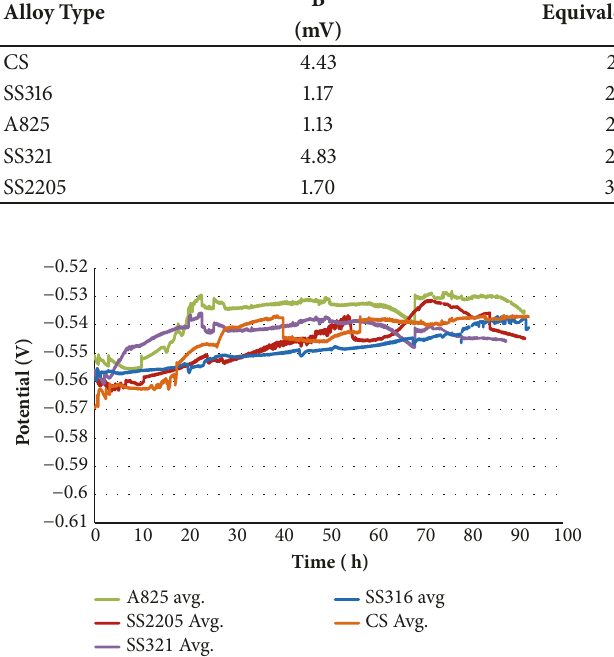
Figure 2: Average potential versus time for all tested alloys in stagnant deaerated 3.5% ABS at 60 ∘ C.